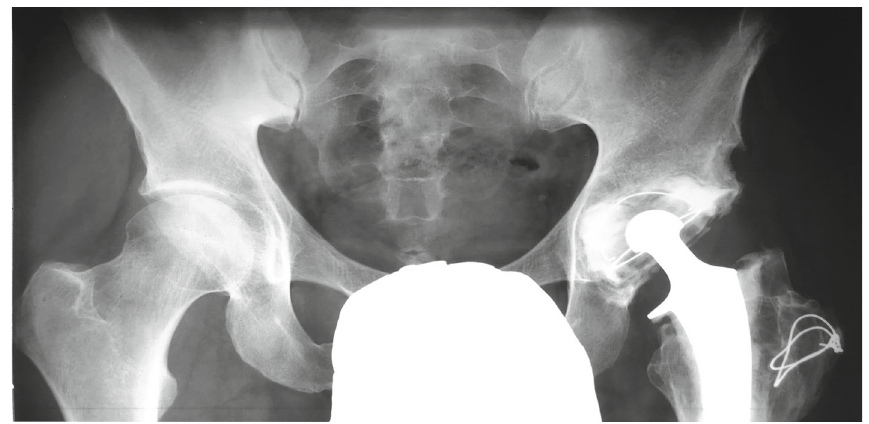
Figure 1: X-ray after primary total hip replacement (1975).